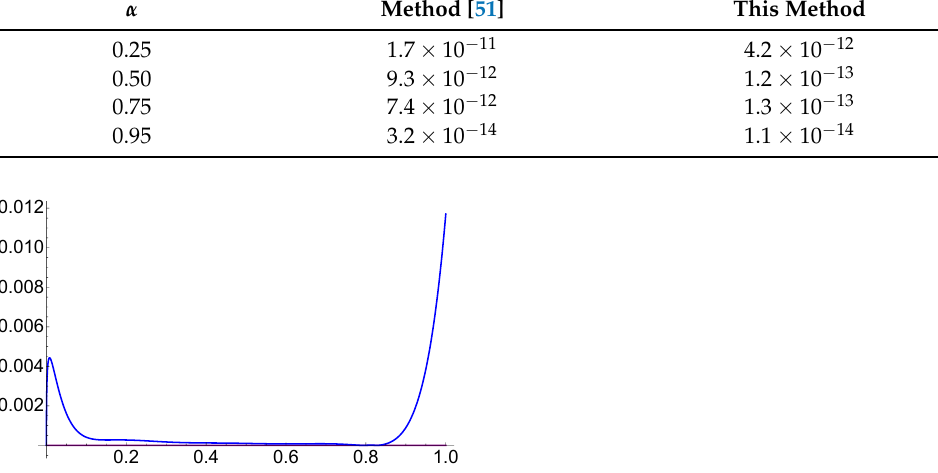
Figure 7. The absolute errors for f ( x ) for α = 0.5 (purple) and α = 1 (blue), for Example 5.